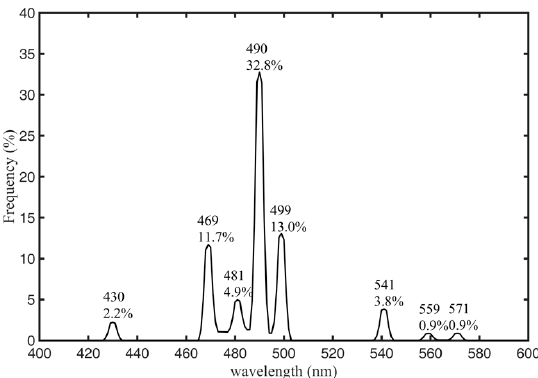
Figure 4. Frequency distribution of the wavelength corresponding to a minimum value of K (cid:2914) .